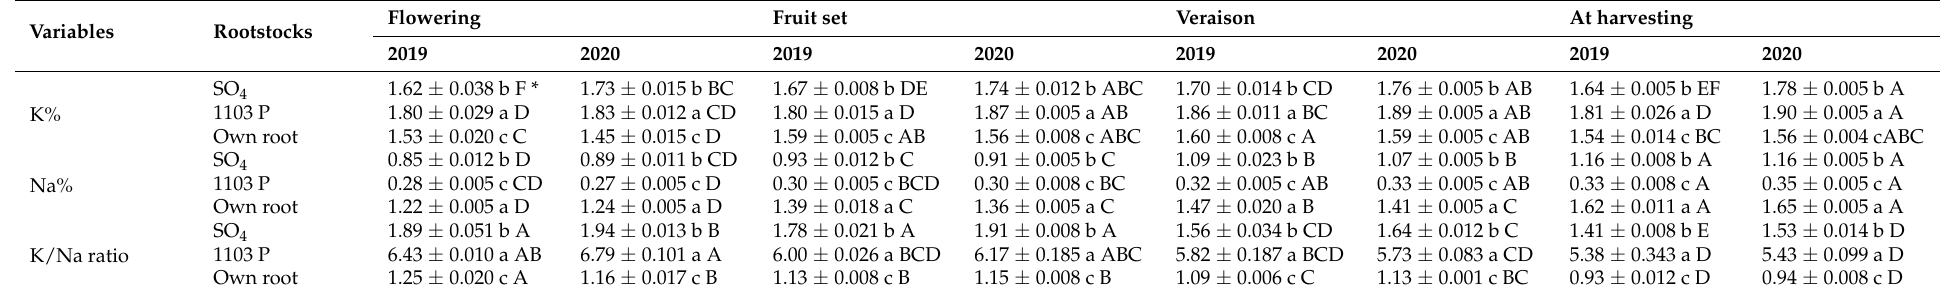
Table 5. The effect of rootstocks (SO 4 , 1103 Paulson, and own root) on potassium content percent (K%), sodium content (Na%), and the K/Na ratio were assessed four times during two growth seasons (2018–2019) on various berry developmental phases (flowering, fruit set, veraison, and at harvest time) of “superior seedless”